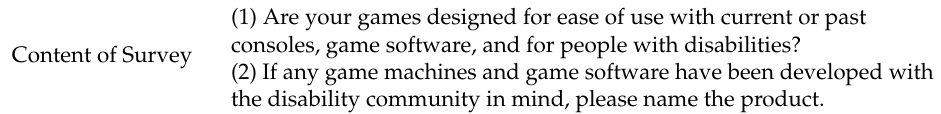
Table 3. Content of the